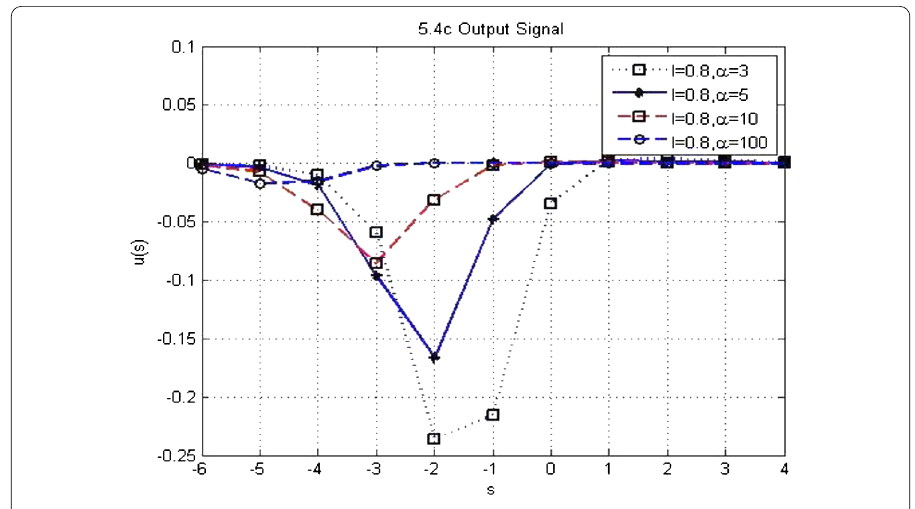
Figure 8 Output signal for (cid:5) = 0.8 and α